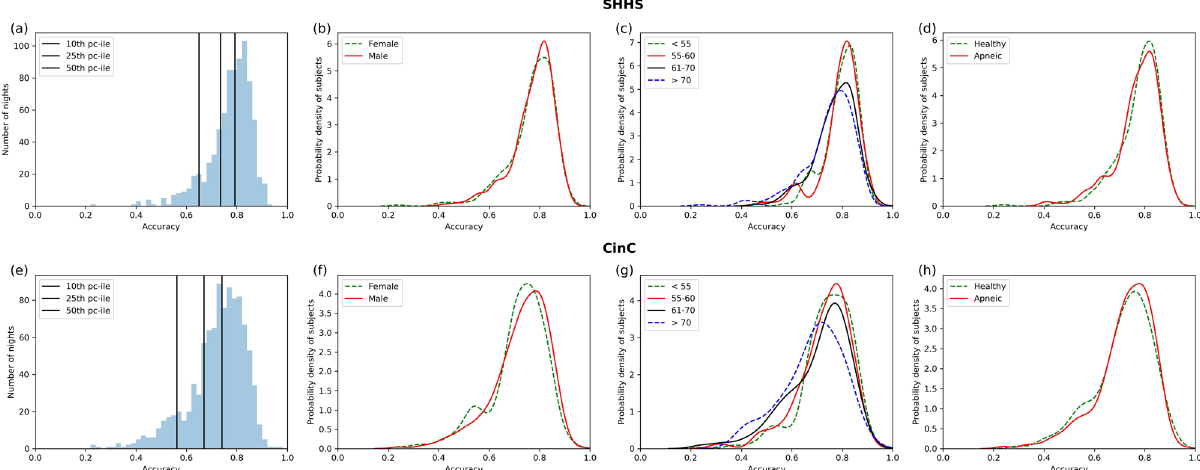
Fig. 4 Night by night accuracy distributions on SHHS and CinC datasets. a , e Histogram of all nights. The black lines mark the 10th, 25th, and the 50 percentile of nights. b , f Probability density distribution of nightly accuracy split by gender. c , g Probability density distribution of nightly accuracy split by age quartiles. d , h Probability density distributions of nightly accuracies split by presence of